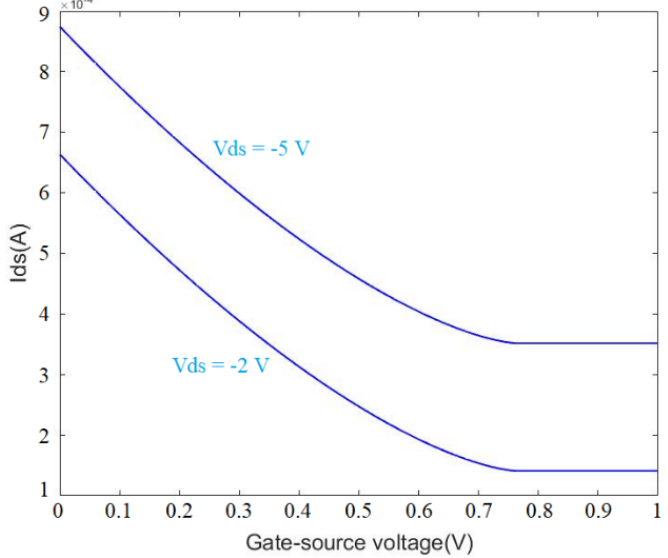
Figure 14. Mathematical modeling result of Ids–Vgs response for Vds values of 2 V and 5 V.